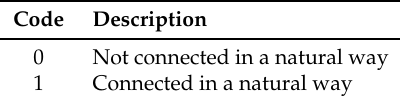
Table A1. Connected or not in a natural way. Mosimann et al. [33] acknowledge obstacles higher than 50cm as effective barriers for surface runoff, preventing connectivity, and so do we.